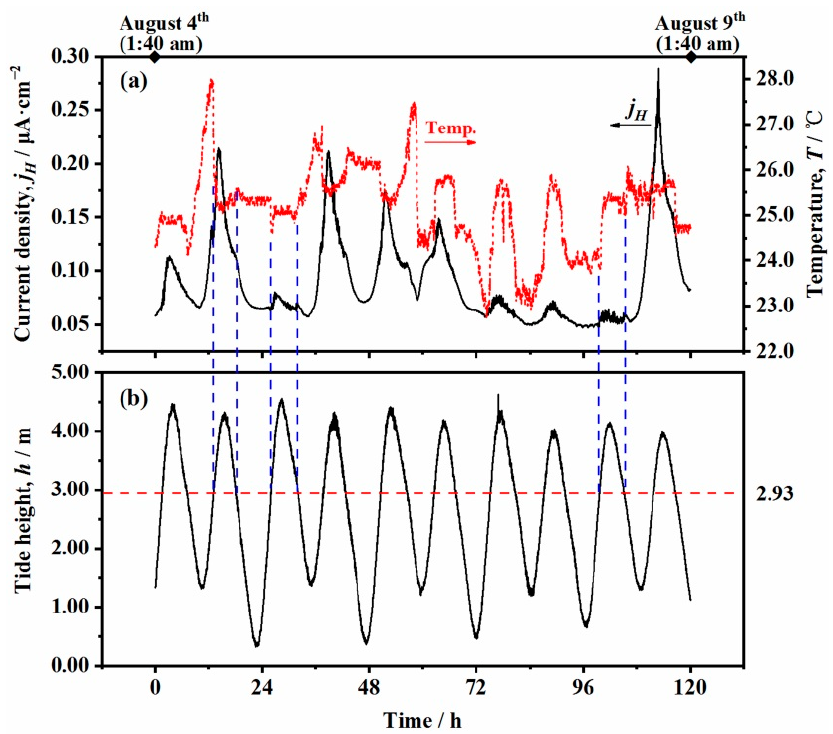
Figure 9. Time variations of the hydrogen permeation current density of the sensor exposed to the tidal zone and the corresponding temperature ( a ), as well as tidal changes ( b ) from 4 August to 9 August during outdoor hydrogen permeation test.